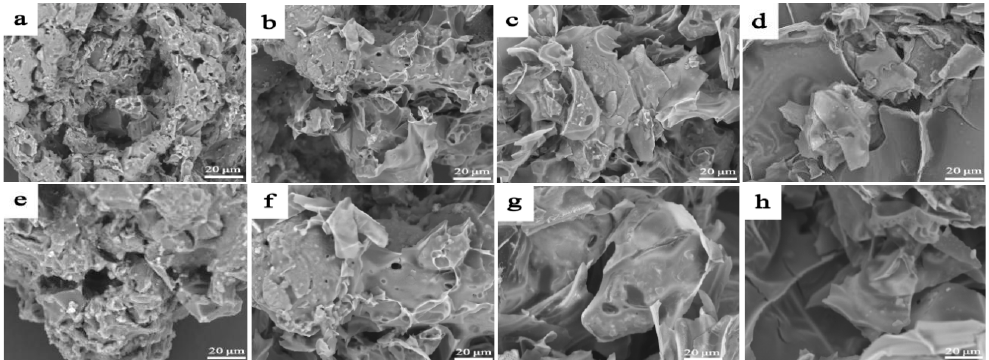
Figure 10. Microscopic morphology of residual carbon from cone-tested composites: mBC/PLA95 ( a , e ); mBC/PLA90 ( b , f ); mBC/PLA85 ( c , g ); and mBC/PLA80 ( d , h ).